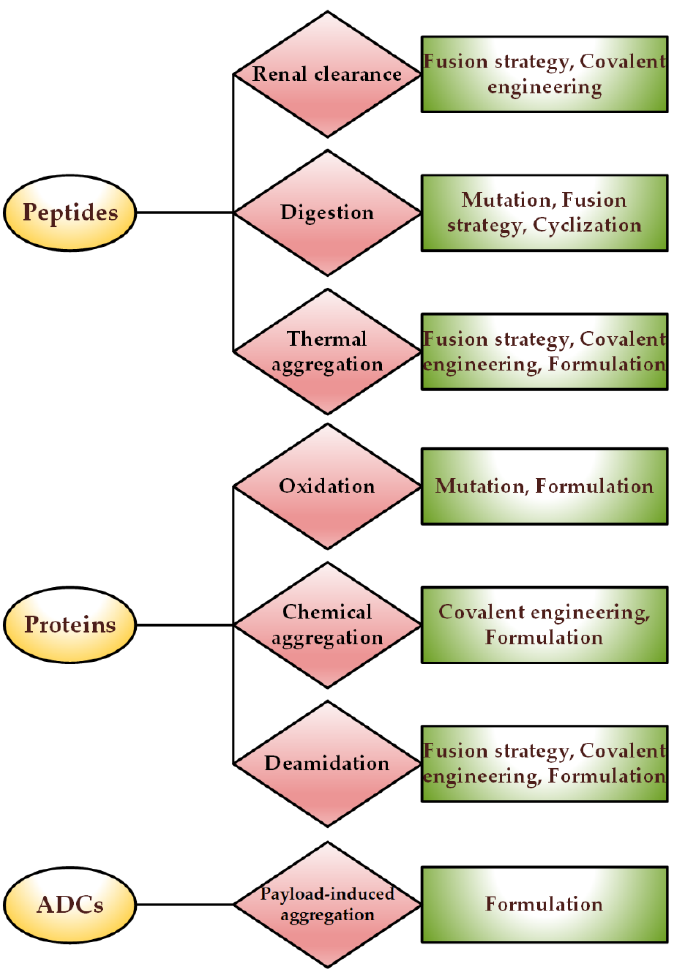
Figure 8. Proposed solutions to the challenges faced by medicinal proteins and peptides.